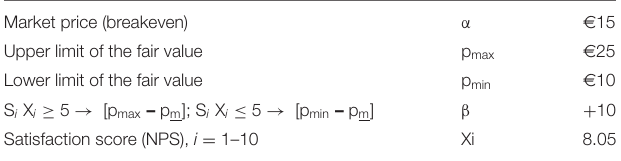
TABLE 1 | Example of net promoter